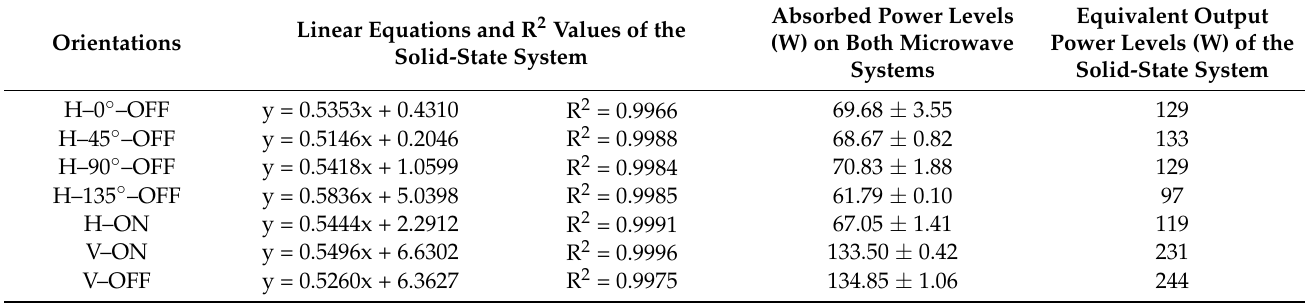
Table 1. Parallel output power levels for both solid-state and magnetron microwave systems for different orientations. In this table, the linear correlations between absorbed and output powers for different sample orientations in the solid-state microwave